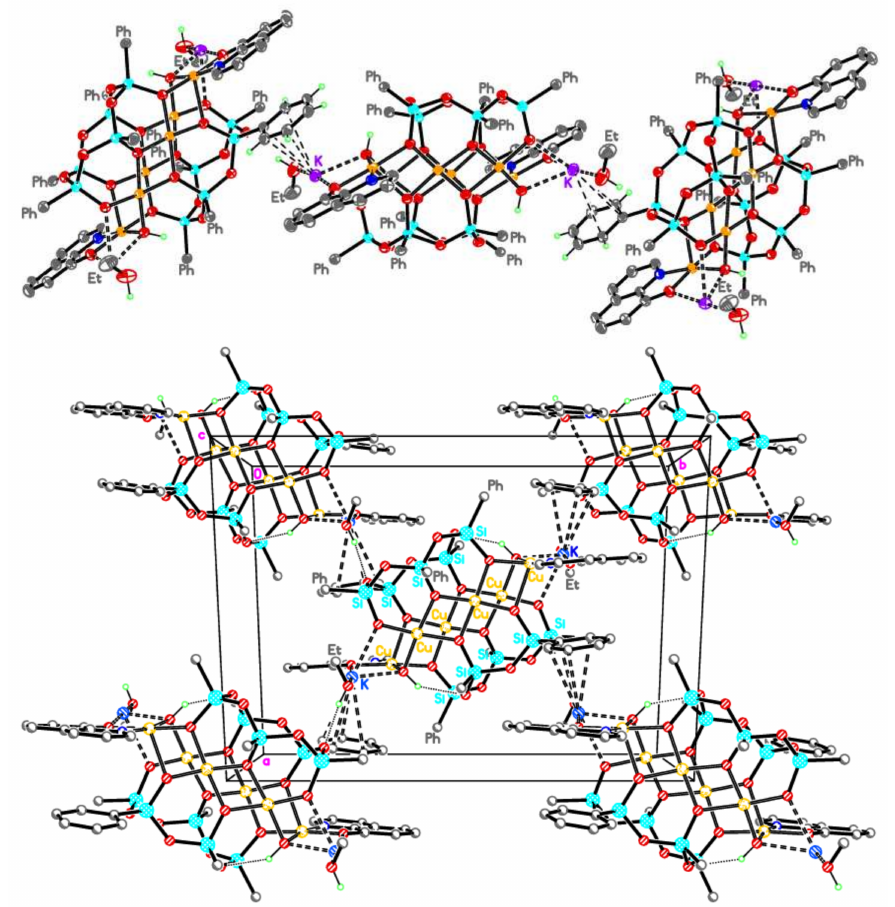
Figure 5. Top . Principle of the metallocene (potassium–phenyl) linkage observed in 5 . Bottom . A fragment of the 2D coordination polymer structure of 5 .